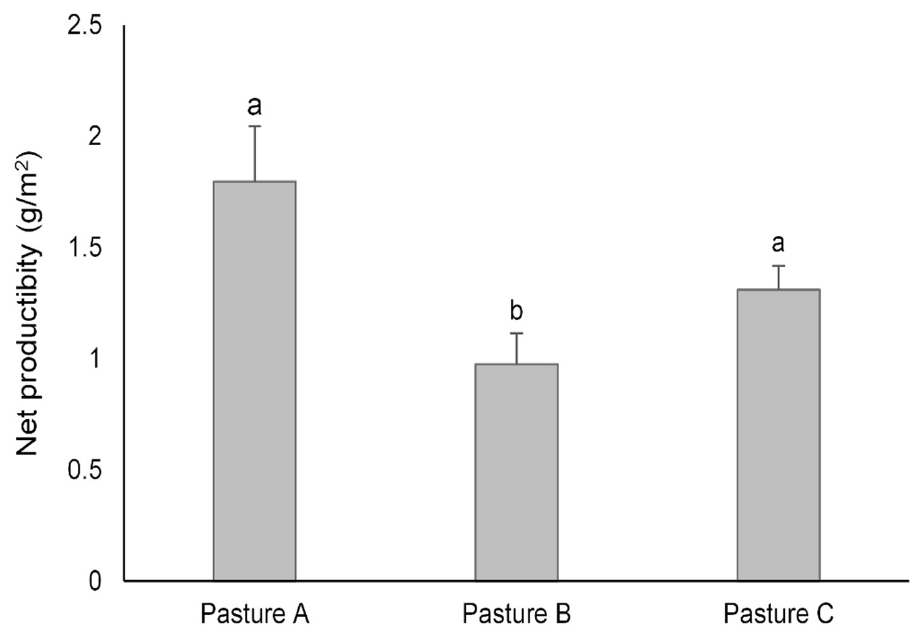
Figure 2. Variation of the net productivity of forage plants among the three pastures (A, B and C). Different letters above each bar indicate significant differences in net productivity among pastures (Tukey test, p < 0.05).